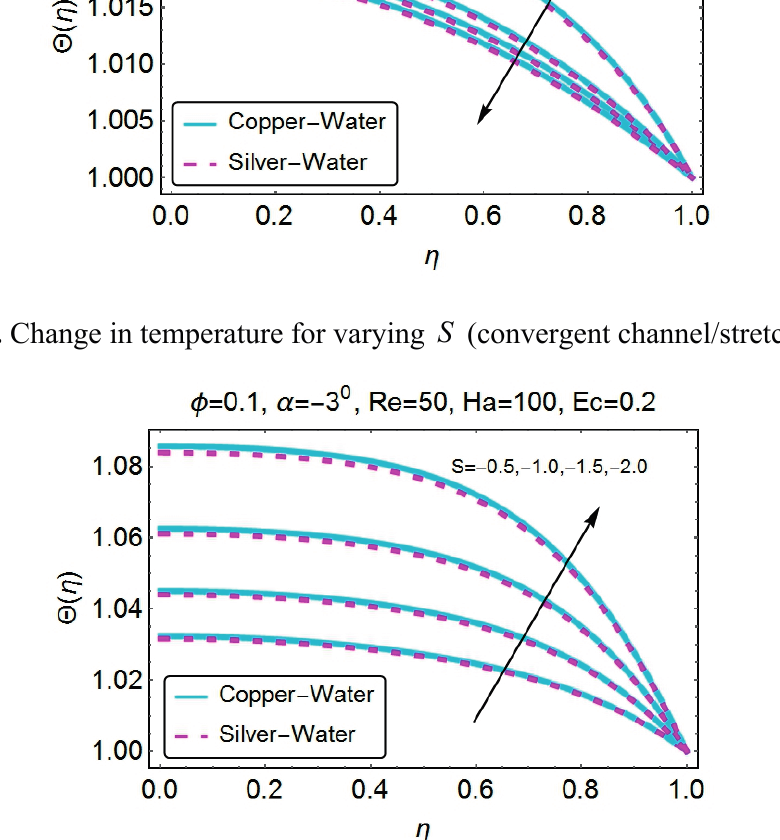
Figure 23. Change in temperature for varying S (convergent channel/shrinking case).